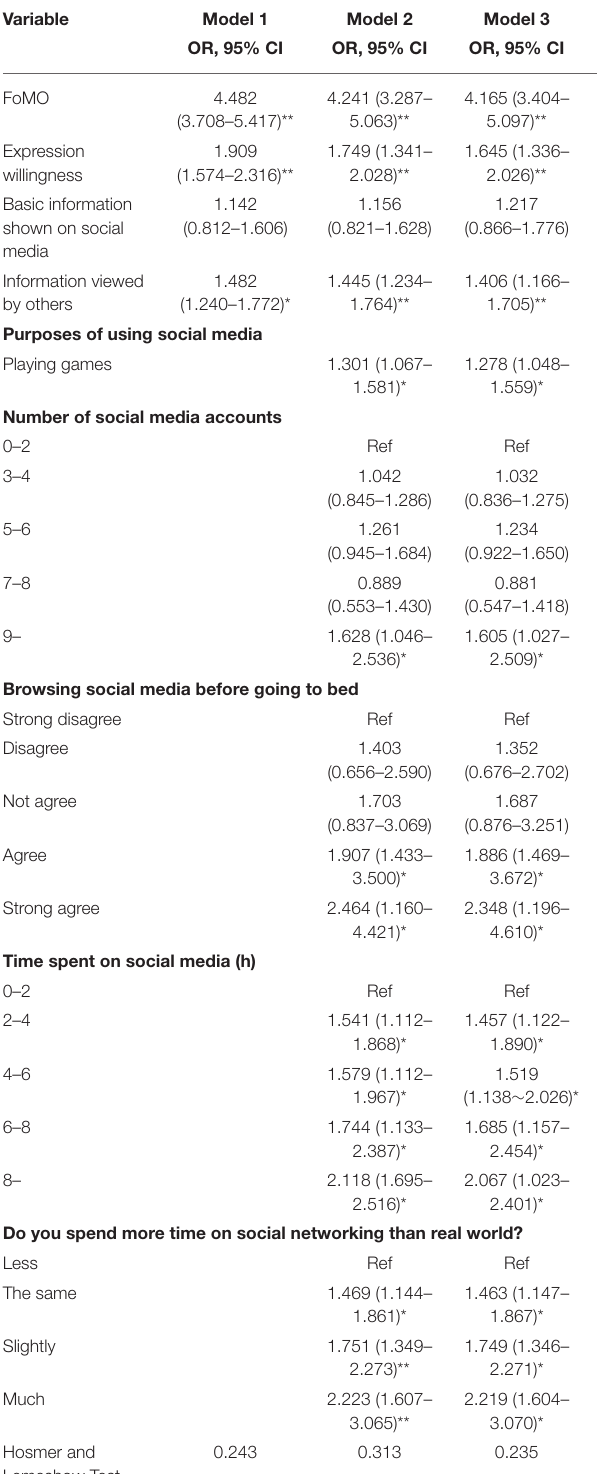
TABLE 4 | Factors associated with SMA among university